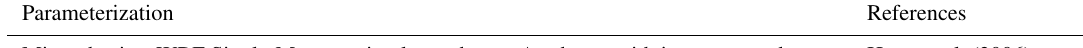
Table 1. Information of the physics options and main features used in the simulations.